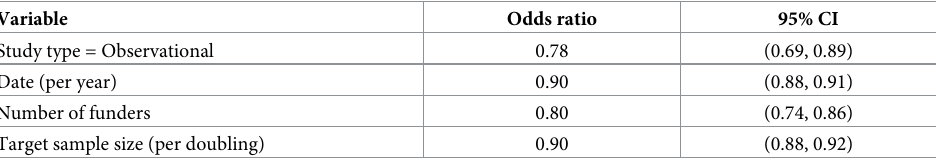
Table 2. Logistic regression results for study characteristics associated with missing statistical methods sections in